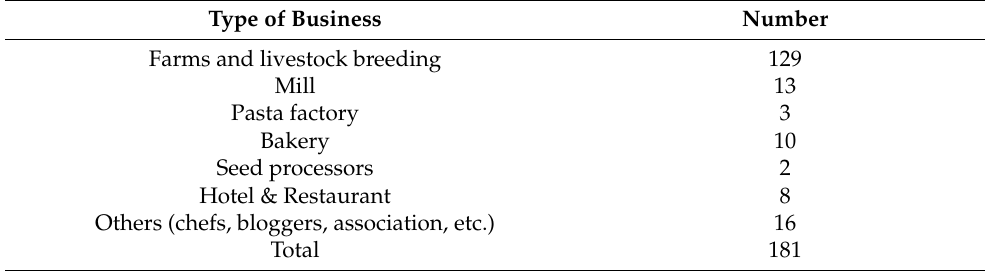
Table 1. Simenza members